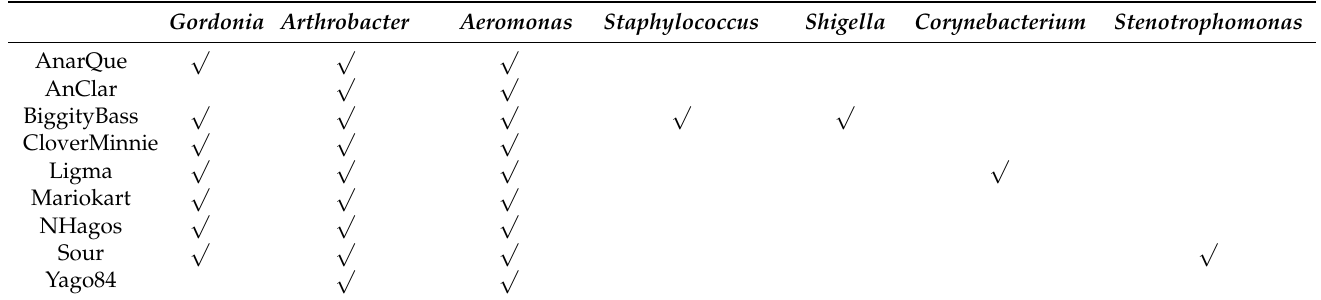
Table 1. Putative host ranges as predicted by PHERI. Putative hosts of the nine Gordonia cluster DR bacteriophages included in this study (Supplementary Table S1) predicted by PHERI [20].